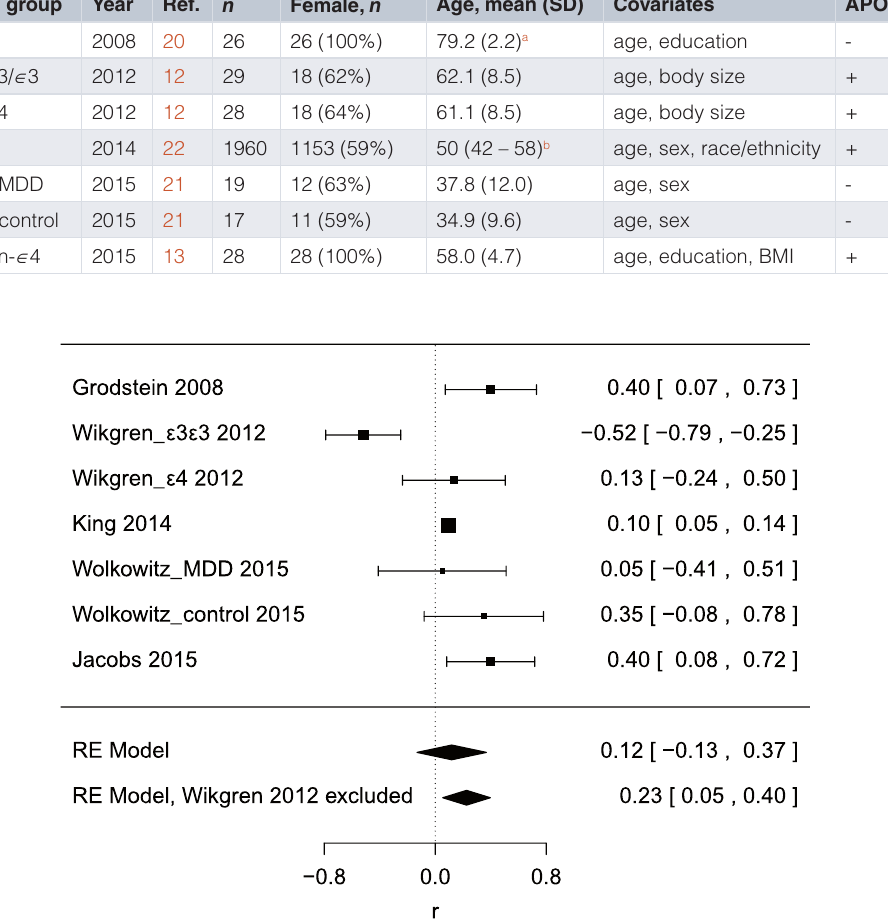
Table 1. Characteristics of included studies. APOE = Apolipoprotein E genotype, investigated (+) or not investigated (-); TA = telomerase activity, investigated (+) or not investigated (-); ∈ 3 & ∈ 4 = APOE alleles; MDD = Major Depressive Disorder; a = Age was not given for imaging subsample, age for whole healthy subsample substituted; b = Median and interquartile range. Study and